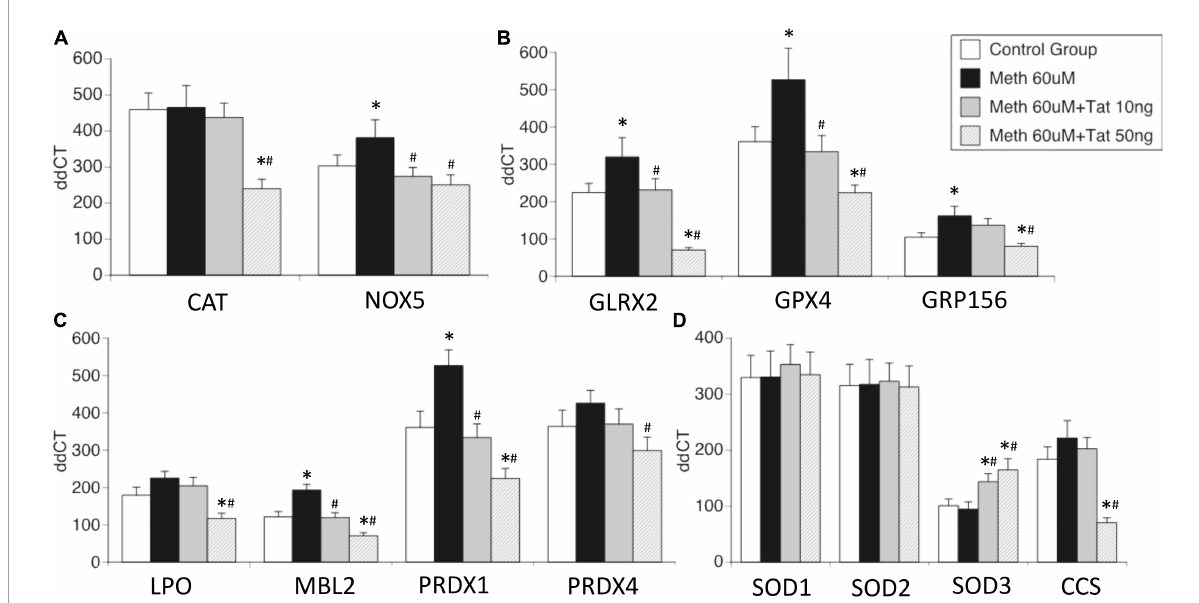
FIGURE3 Effects of HIV Tat on Meth-induced transcriptional changes in oxidative stress-relevant genes. Validation was performed in selected genes most relevant in innate immune oxidative metabolism and detoxification in controls and in THP1 macrophages stimulated with Meth (60uM), in the presence and absence of HIV Tat at 10 and 50ng/ml. (A) Catalase CAT and NADPH oxidase 5 (NOX5); (B) Glutaredoxin 2 (GLRX2), Glutathione peroxidase 4 (GPX4, membrane associated), GABA b receptor (GRP156); (C) Lactoperoxidase (LPO), Mannose-binding lectin 2 (MBL2), Peroxiredoxins 1 and 4 (PRDX1 and PRDX4); (D) Superoxide dismutases 1, 2, 3 (SOD1, SOD2, SOD3), and Cu-chaperone for SODs (CCS). Values correspond to the mean ± SD of 3 independent experiments performed in duplicate. * p < 0.05 compared to vehicle stimulated controls, # p < 0.05 compared to Meth only in Bonferroni’s post hoc test.